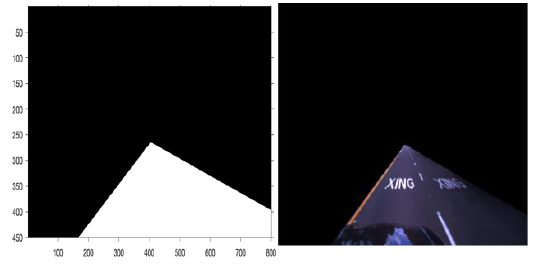
Figure 8. Image mask (left), segmented image (right)